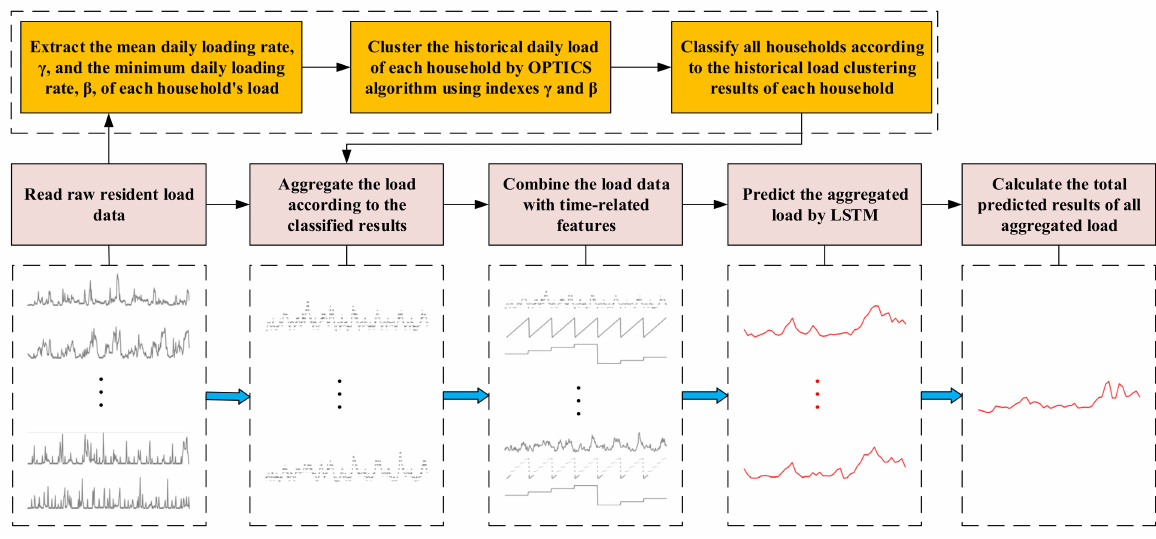
Figure 5. The detailed residential load prediction process of our proposed